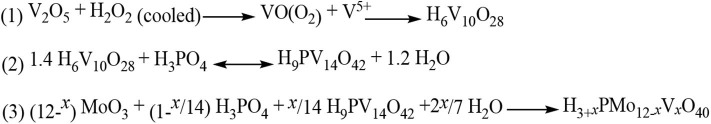
The overall scheme for the synthesis of Mo-V-P HPA catalysts.